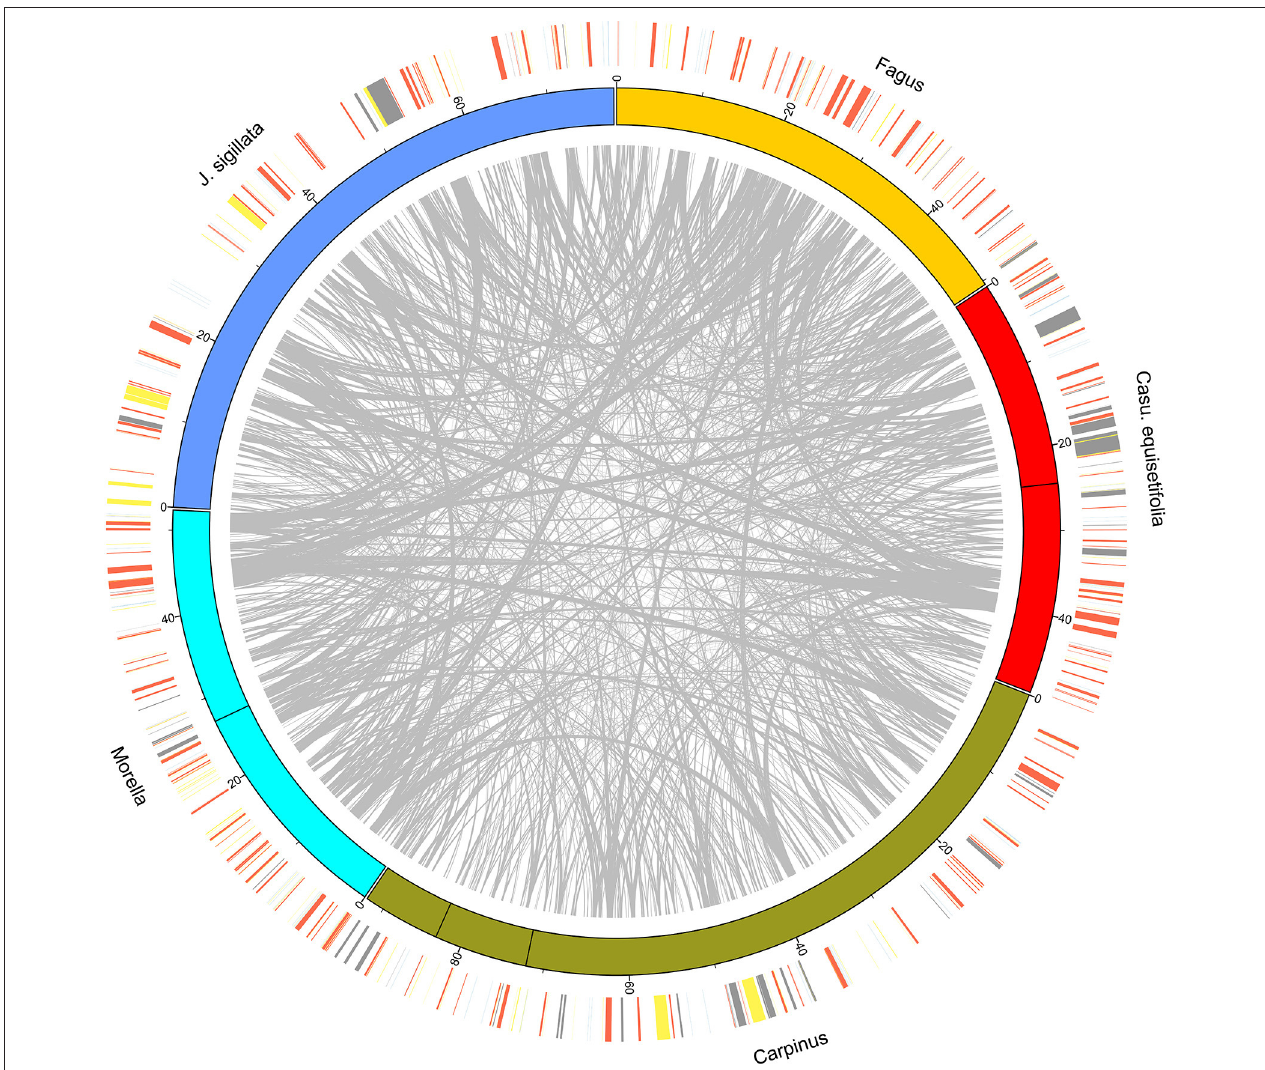
FIGURE 2 | CIRCOS plot of species from five families. The longest mitogenomes of each family were used. The outer ring shows the position of protein-coding genes and rRNA (red), tRNA (blue), repeat (yellow), and MTPT (gray)